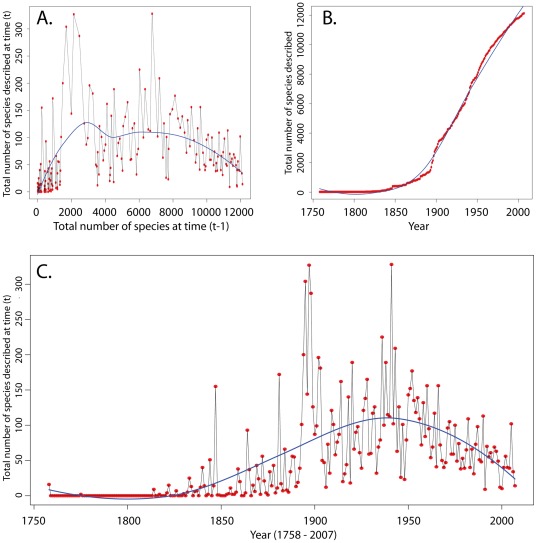
Plots showing millipede taxonomic effort over time in terms of species descriptions.Plot A shows the data as used to calculate global species diversity following the methods of Bebber et al.
[39]. The y-axis corresponds to the number of species descriptions in a given year (t) while the x-axis shows the number of species accumulated at time “t-1”. A local regression line is shown fitted to the data. Plot B shows a species accumulation curve fitted with a local regression line with no trend toward asymptote. Plot C shows the taxonomic productivity over time in terms of species descriptions published yearly and is fitted with a local regression line.